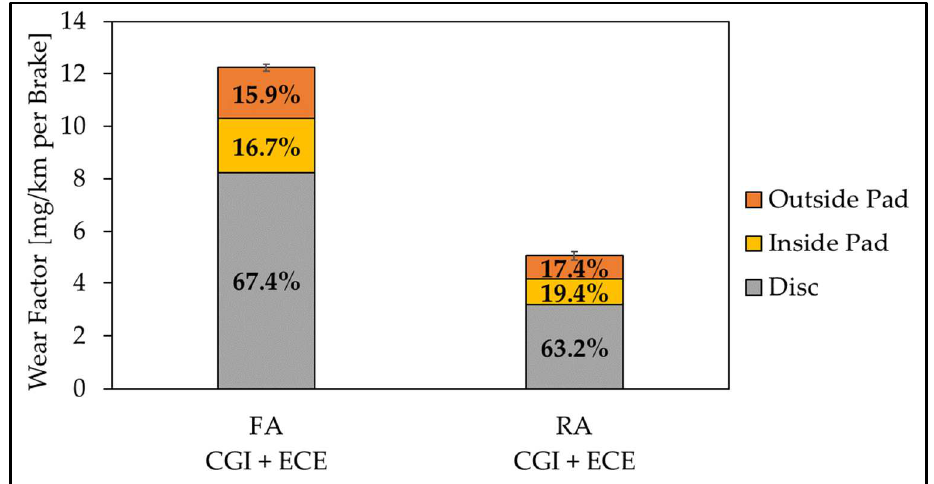
Figure 3. Wear factors of the C-segment vehicle front and rear-axle disc brakes after 8× WLTP Brake Cycle.